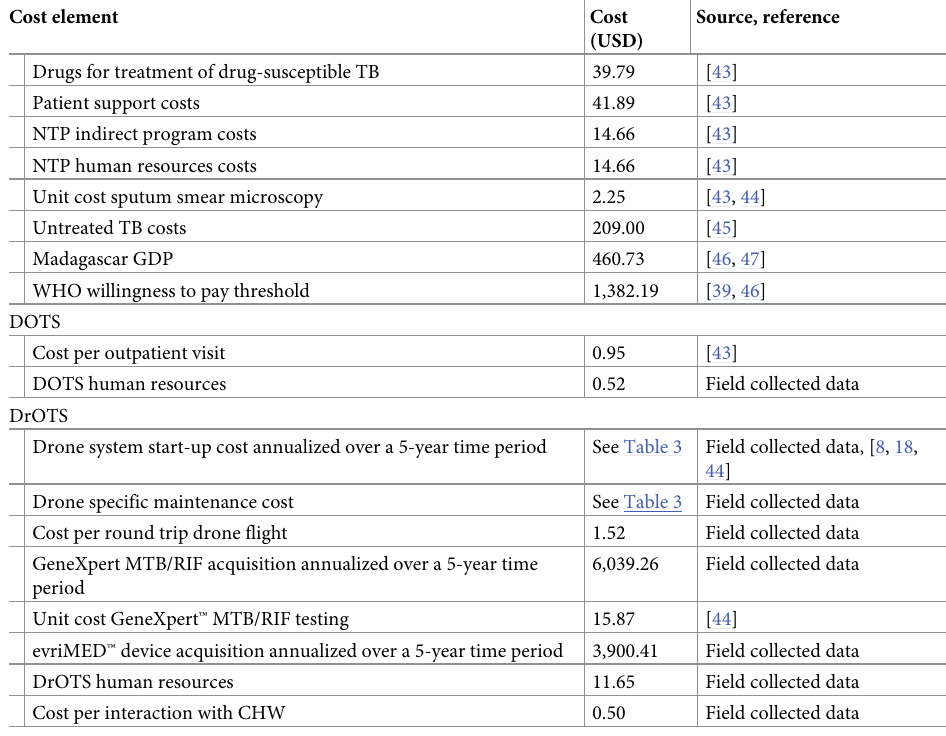
Table 2. DOTS and DrOTS elements of